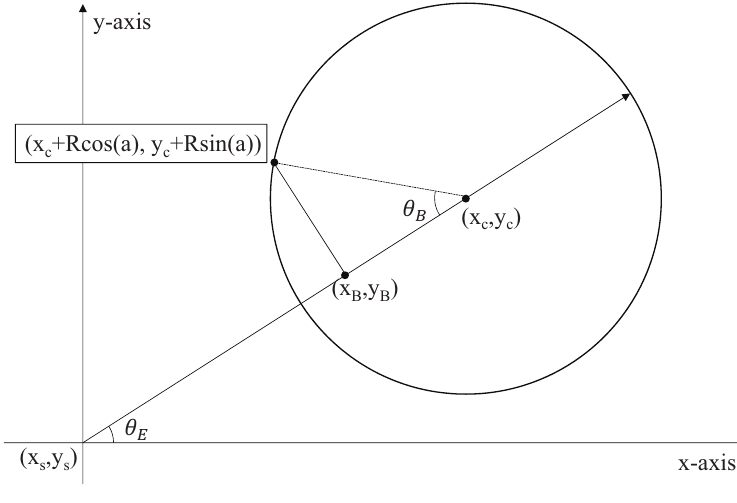
Figure 3. Branching point and termination of